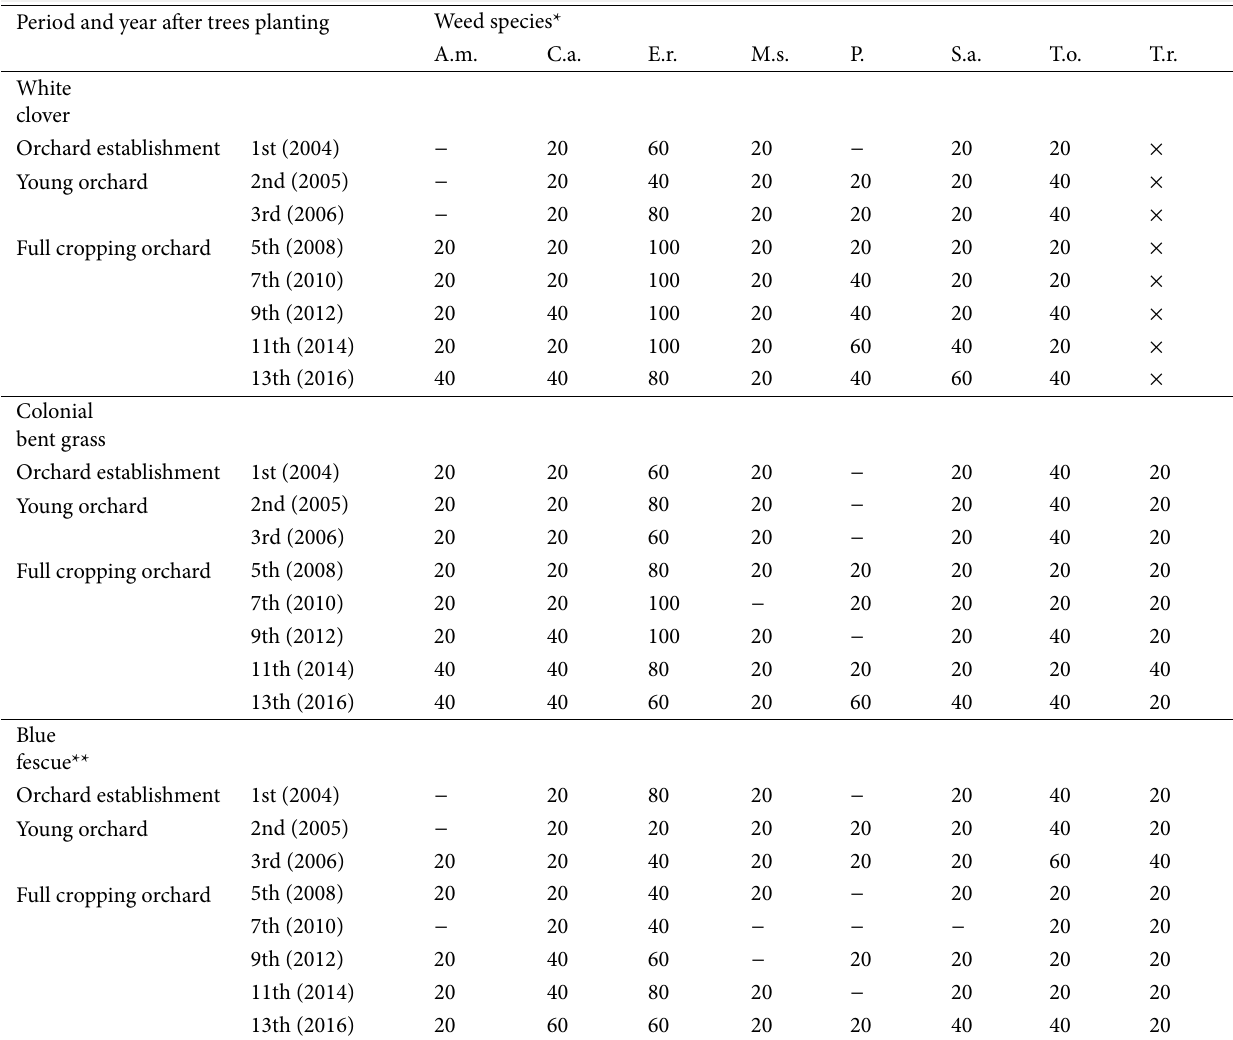
Table 5 Change in the mean percentage of the soil surface under the most important perennial weed cover in the tree rows with the living mulch sod, in the succeeding years 2004 −